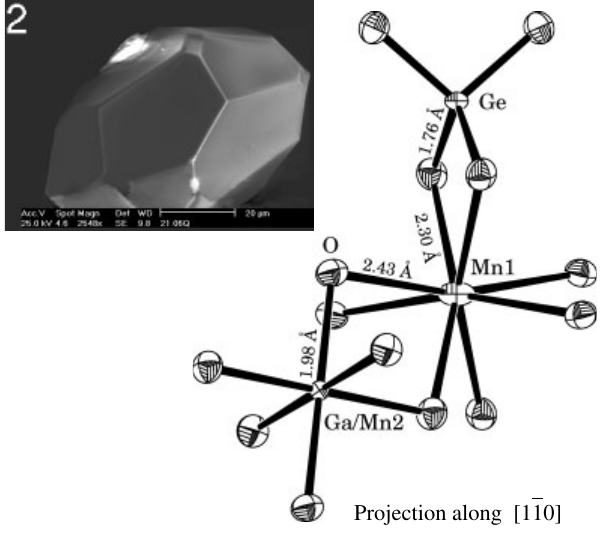
Table 3. Data collection and